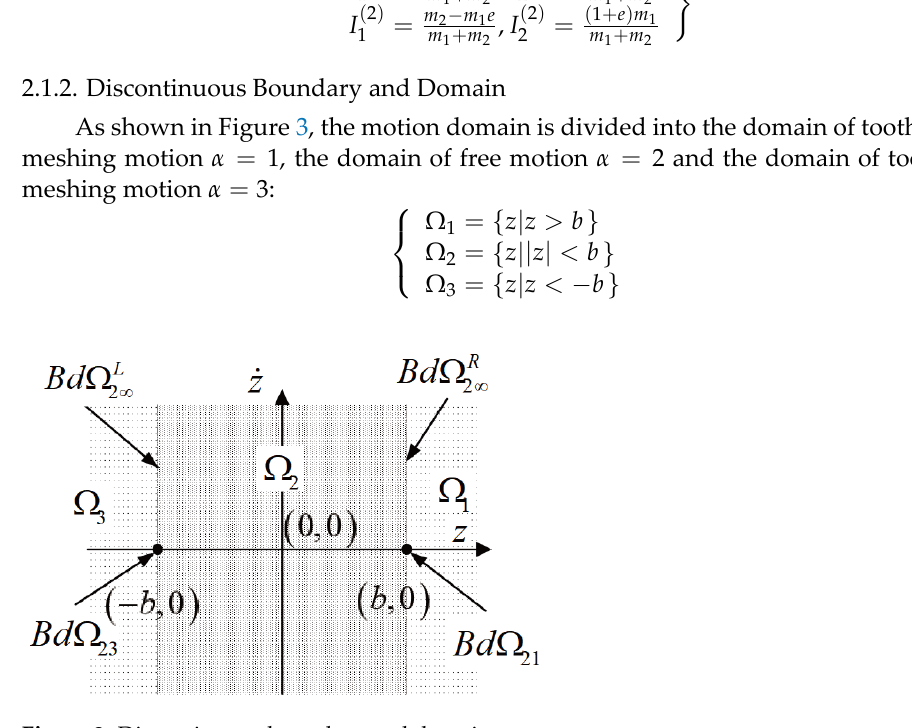
Figure 3. Discontinuous boundary and domain.